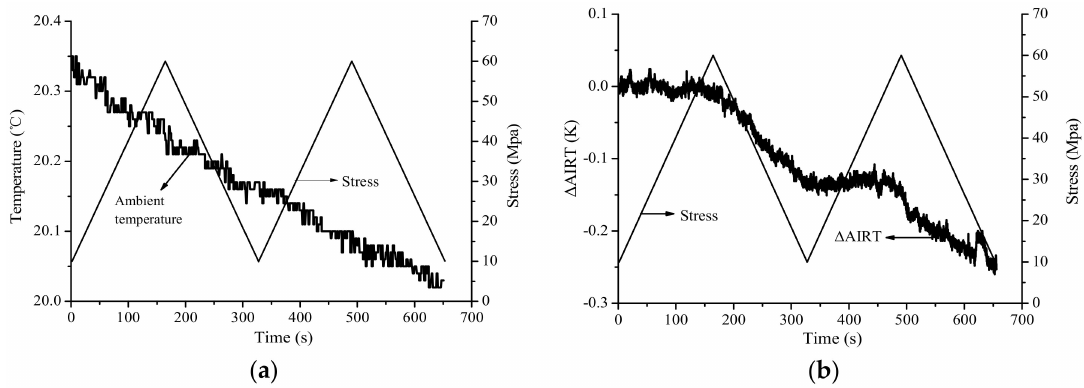
Figure 4. The measured results of sample HG-1 in the cyclic loading process: ( a ) The ambient temperature change; ( b ) ∆ AIRT